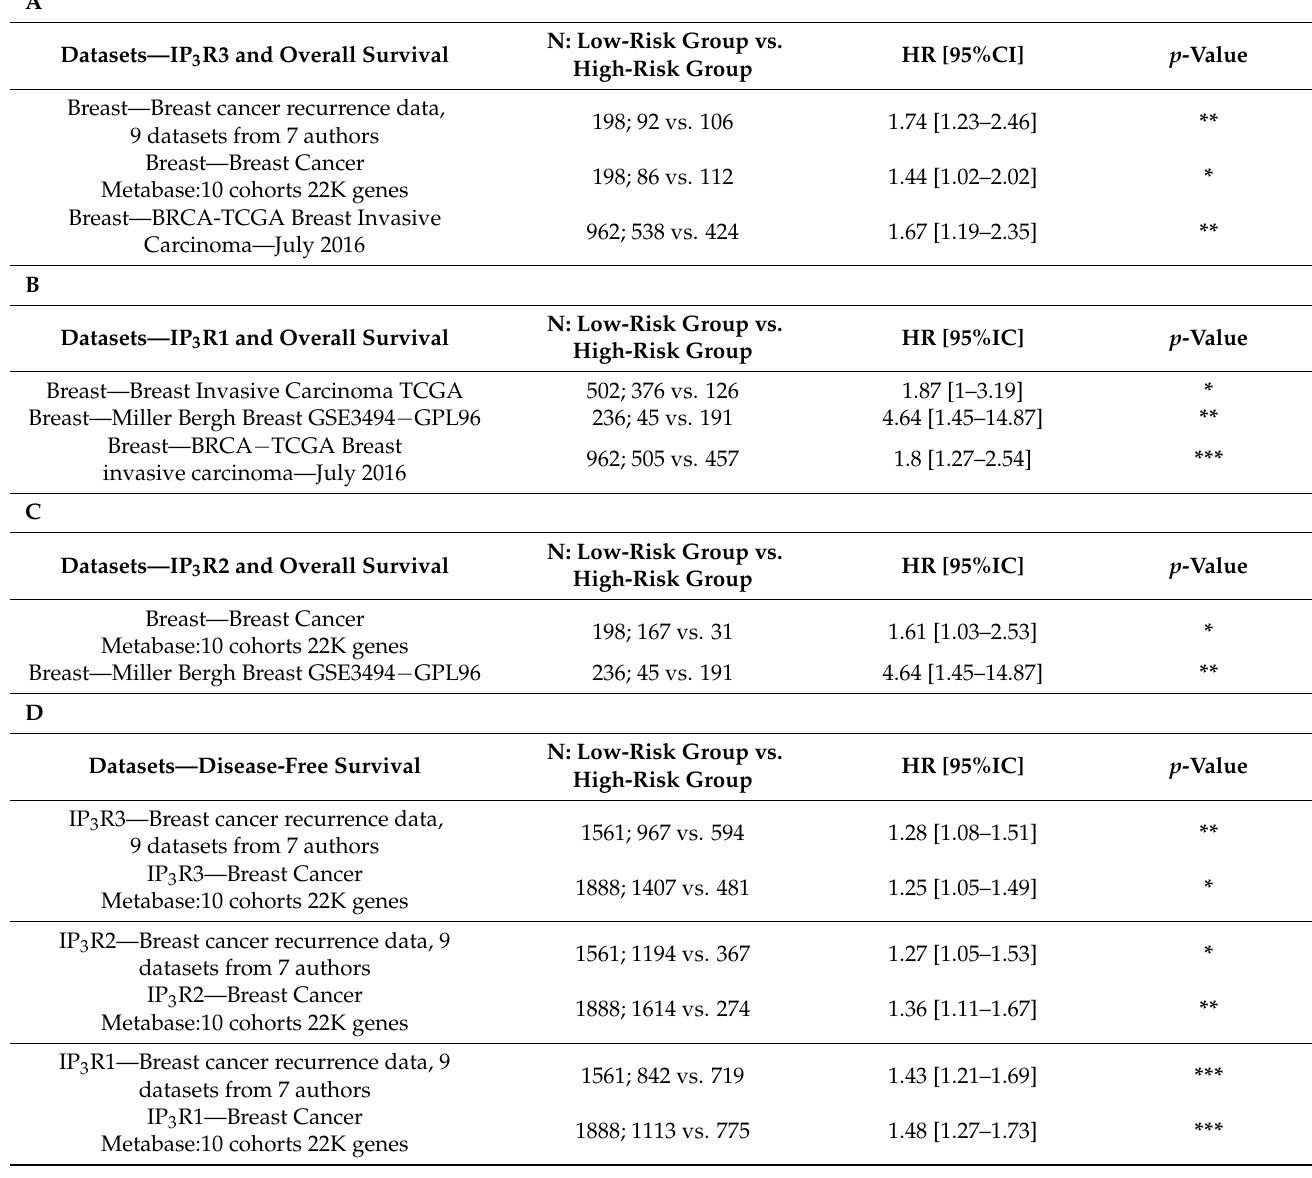
Table 3. Statistically significant correlations between IP 3 R subtype expression and survival. IP 3 R3 and IP 3 R1 expression levels were significantly associated with worse overall survival in three datasets (comprising 1358 patients (A) and 1700 patients (B), respectively), and IP 3 R2 was significantly associated with worse overall survival in two datasets (comprising 434 patients) (C). Expression of the three IP 3 R subtypes was significantly associated with worse recurrence-free survival in